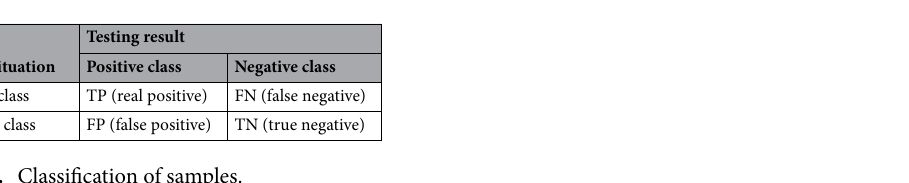
Table 1. Classification of